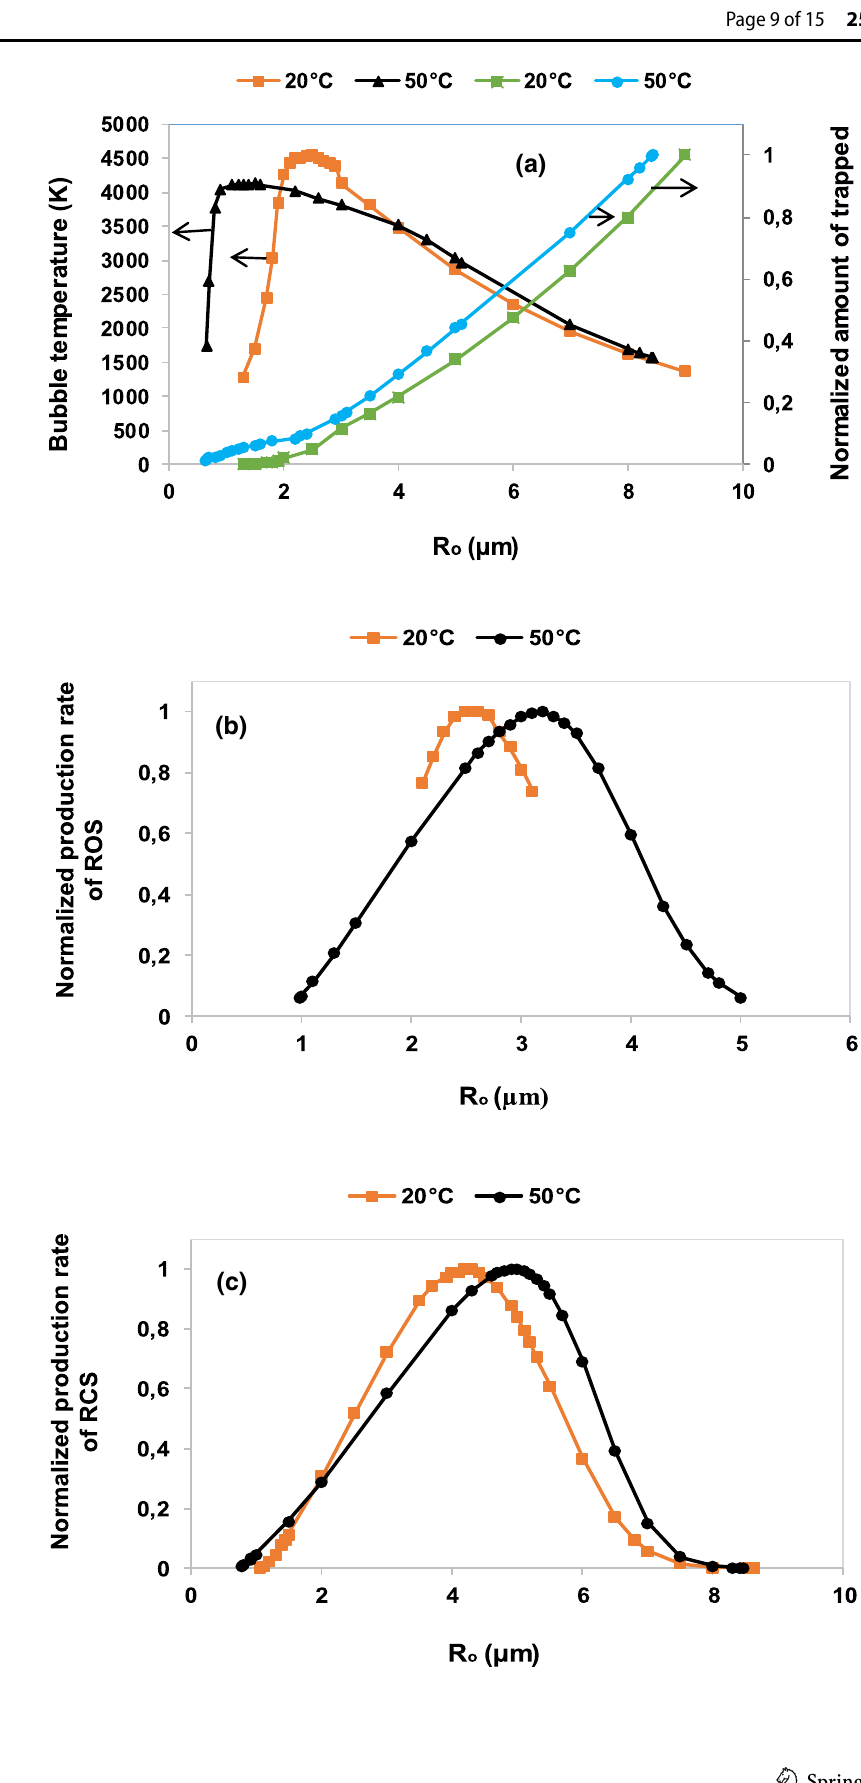
Fig. 3 a Evolution of water vapor amount and the maxi- mum bubble temperature at the collapse for an argon bubble (0 mM of CCl 4 in solution) as a function of ambient bubble radius ( R 0 ) for two liquid tem- peratures (20 and 50 °C). b Nor- malized production rate of